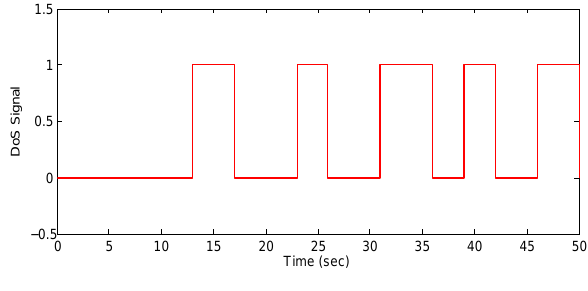
Figure 12. DoS attack signal.